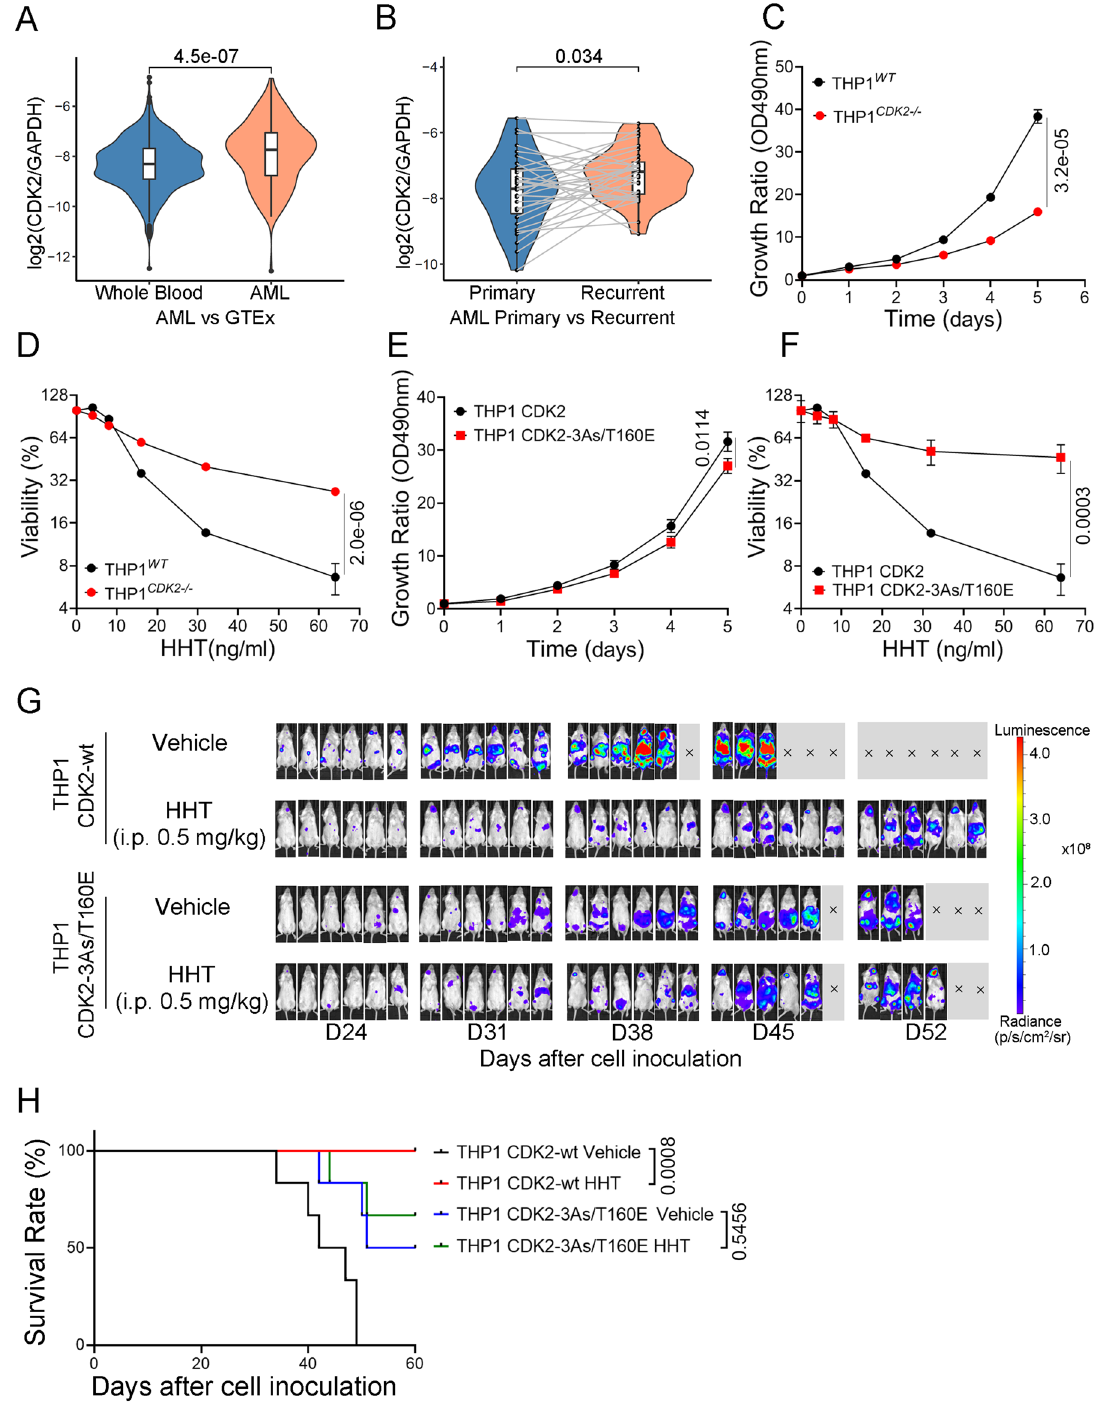
Fig. 2 CDK2 is critical for AML proliferation. A Normalized expression level (TPM) of CDK2 relative to GAPDH in TARGET-AML ( n = 156) and GTEx cohort ( n = 1582). B Normalized expression level (TPM) of CDK2 relative to GAPDH in primary and recurred samples using TARGET-AML ( n = 31). Box boundaries in A , B are the 25th and 75th percentiles, the horizontal line across the box is the median, and the whiskers indicate the minimum and maximum values. Wilcoxon Test were used in statistical analysis for A , B . C Growth curves of THP1 wild-type and THP1 CDK2 knockout cells. D Cell survival curve of THP1 wild-type and THP1 CDK2 knockout cells after HHT treatment for 24 hours. E Growth curves of THP1 CDK2 and THP1 CDK2-3As/ T160E cells. F Cell survival curve of THP1 CDK2 and THP1 CDK2-3As/T106E cells after HHT treatment for 24 hours. Data presented as mean ± SD from four independent biological samples for each group for C – F . P values are indicated by two-tailed unpaired Student ’ s t test for C – F . G Bioluminescence imaging of luciferase-expressing THP1 (CDK2-wt or CDK2-3As/T160E) xenograft mice models, treated with 0.5 mg/kg HHT (Six mice for each group). H Kaplan – Meier survival of luciferase-expressing THP1(CDK2-wt or CDK2-3As/T160E) xenograft mice models, treated with 0.5 mg/kg HHT or vehicle as the control. P values are calculated by the log-rank test. Source data are provided as a Source data fi le.